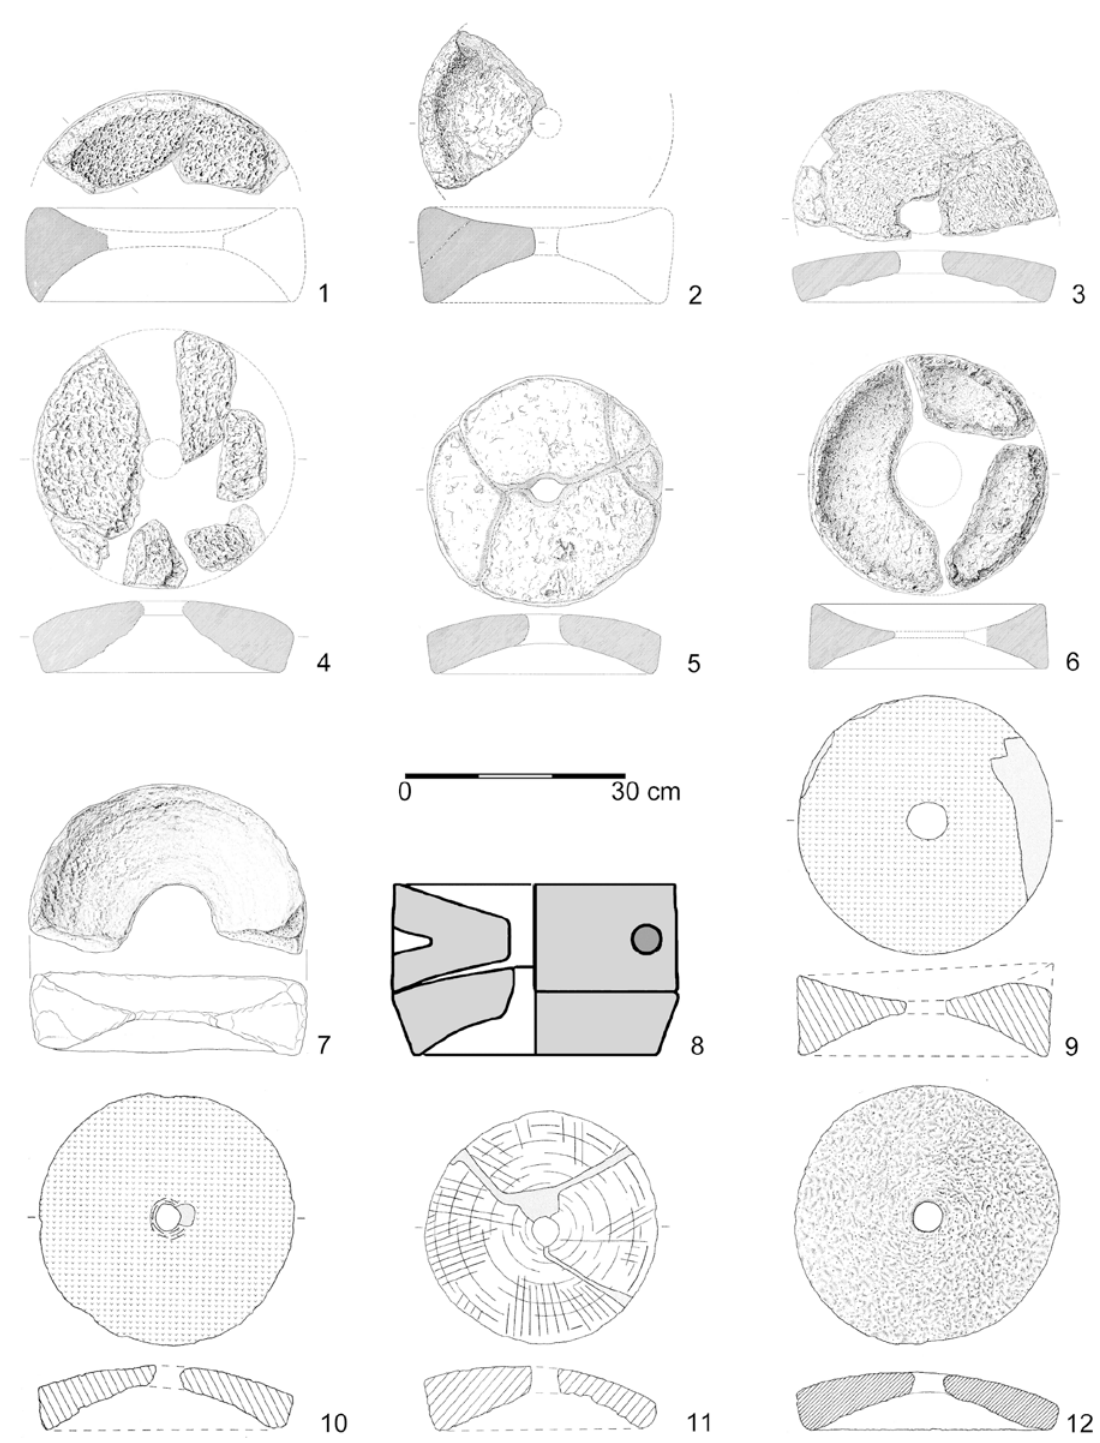
Figure 5. Iron Age quernstones of Brillerij type. 1-2,6,7, 9: upper stones; 3-5,10-12: lower stones; 8: lower and upper stone. Provenances: 1-4. Eschweiler-Laurenzberg; 5. Eschweiler-Lohn; 6. Petersberg near Königswinter; 7. Niederzier-Hambach; 8. oppidum “Fosse des Pandours” near Saverne; 9-10. Bad Nauheim; 11. oppidum Dünsberg near Biebertal-Fellinghausen; 12. oppdidum Trînchy near Cugnon. All “basalt”-like lava. (1-5. Joachim 1980: fig. 25:2, 27:4, 16:4, 17:4, 46:5; 6. Joachim 1982a: fig. 15:3; 7. Joachim 2009: Pl. 20:11; 8. Jodry & Féliu 2009: fig. 5; 9-11. Wefers 2012a: pl. 10:47, 11:49; 12. Matthys & Hossey 1979: fig.